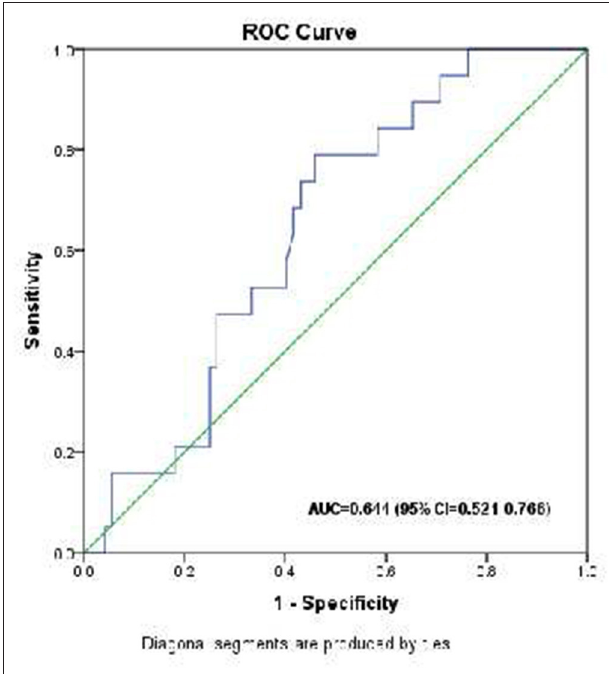
FIGURE 2 | Receiver operating characteristic (ROC) curve analysis for HOMA- β % in the prediction of mortality in critically ill